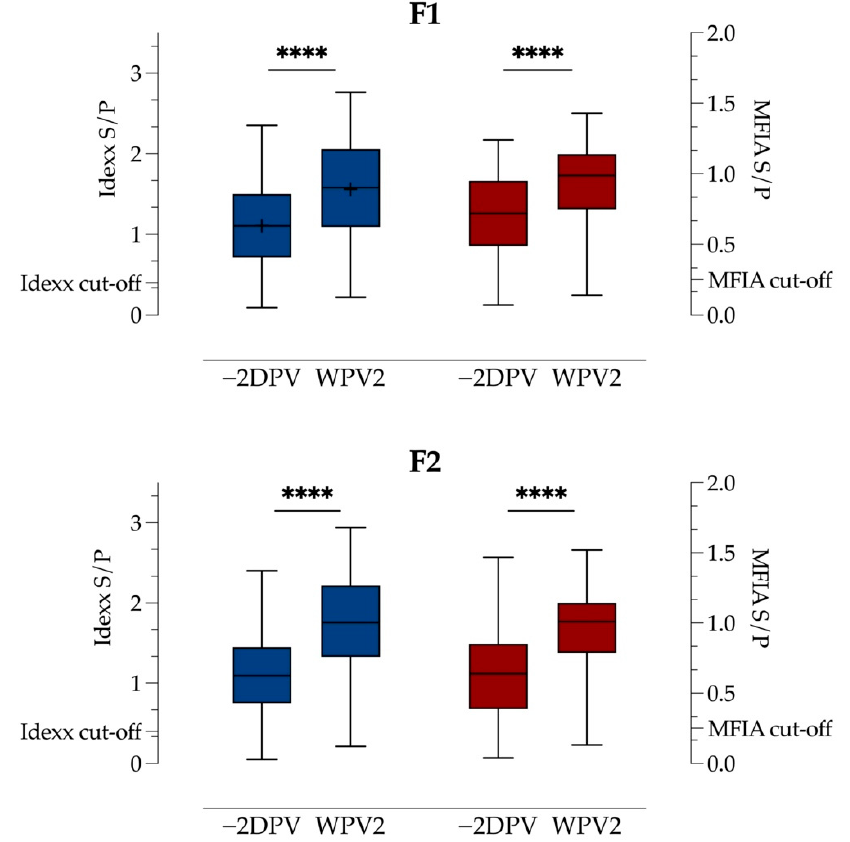
Figure 1. Boxplots showing S/P results of Idexx ELISA (blue) on the first y ‐ axis and MFIA (red) on the second y -axis for Farms 1 (F1) and 2 (F2), before ( − 2DPV) and after (WPV2) mass vaccination with a PRRSV ‐ 1 MLV vaccine as minimum, median and maximum as well as quartiles of 25, 50, 75. The cut ‐ off for each assay is given on each axis. “+” indicates mean. **** is p < 0.0001 as result of the comparison of results − 2DPV and WPV2for each analysis.